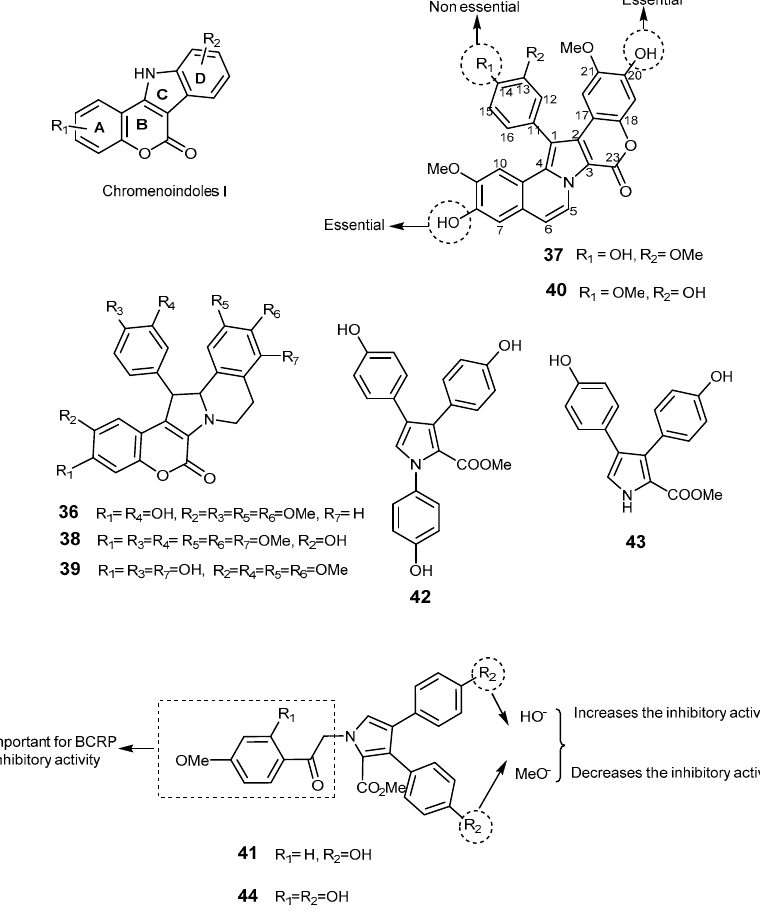
Figure 8. The scaffold of lamellarins and their representatives 36 – 44 . SAR studies for lamellarin D ( 37 ) and lamellarin O ( 41 ) regarding antitumor activity on BCRP overexpressing cells.